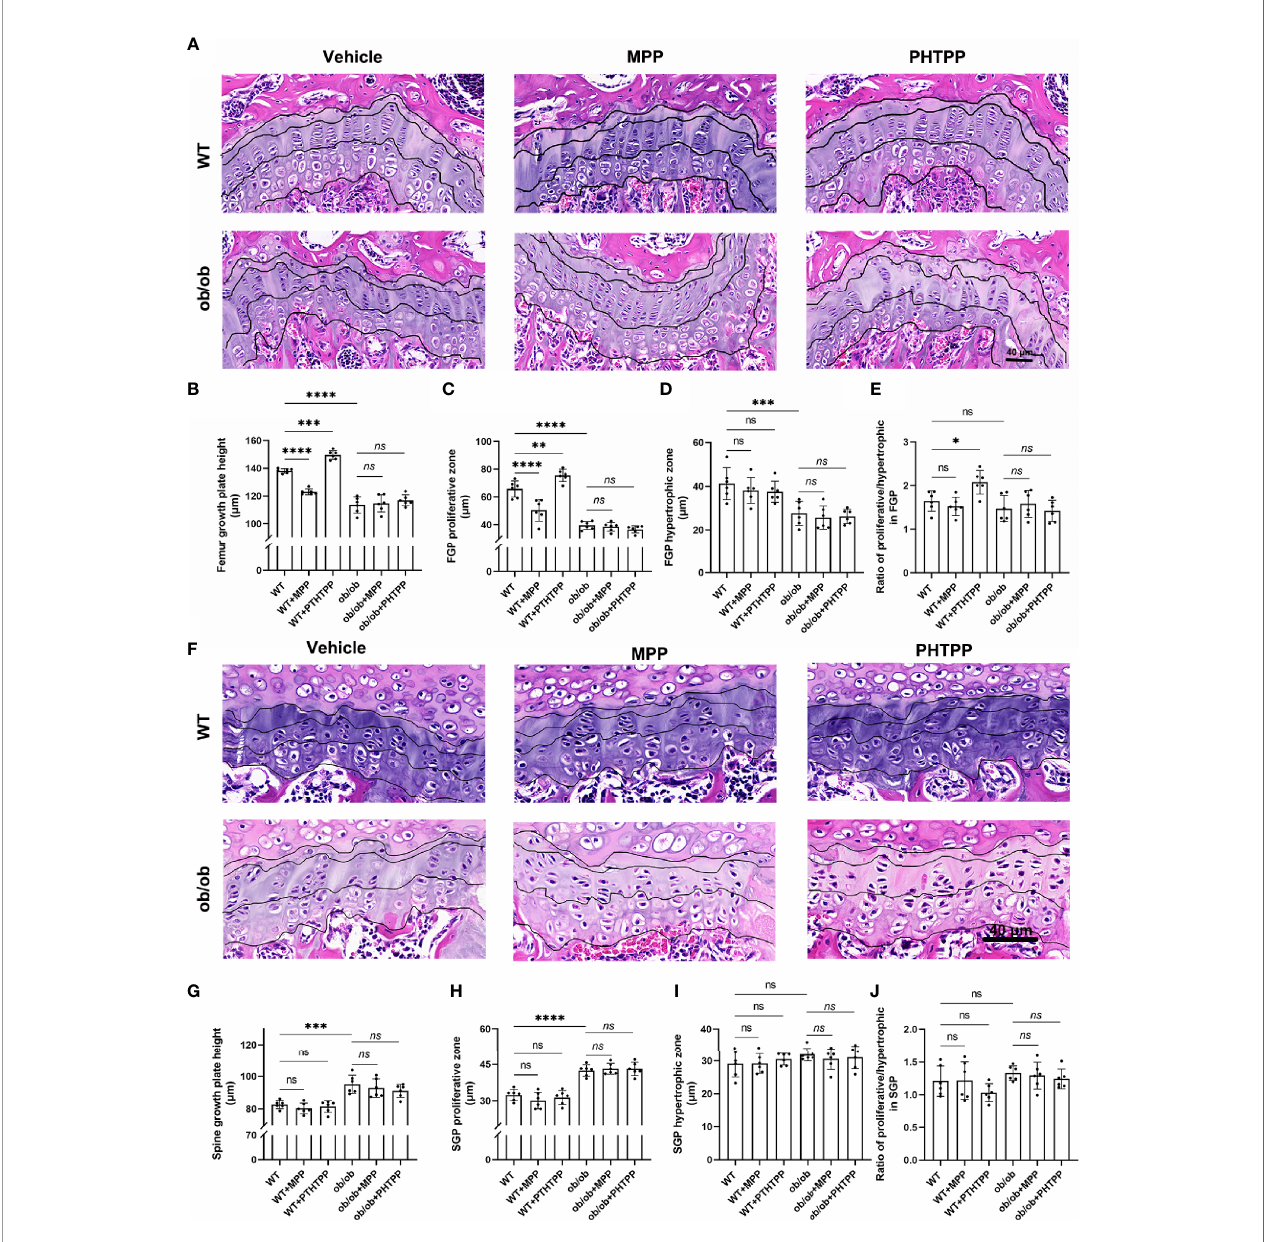
FIGURE 7 | Leptin de fi ciency disturbs the regulatory effects of estrogen receptor-selective antagonists on the femur growth plate (GP) thickness and proliferative and hypertrophic zone using H&E staining method (A – E) . (A) Femur GP H&E staining. (B) The height of GP in the femur GP. (C) The height of proliferative zone in the femur GP. (D) The height of hypertrophic zone in femur GP. (E) Ratios of proliferative/hypertrophic zones in femur GP. Leptin de fi ciency disturbs the regulatory effects of estrogen receptor-selective antagonists on the vertebral GP length, and proliferative and hypertrophic zone using H&E staining method (F – J) . (F) Vertebral GP H&E staining. (G) The height of GP in the vertebral GP. (H) The height of proliferative zone in the vertebral GP. (I) The height of hypertrophic zone in vertebral GP. (J) Ratios of proliferative/hypertrophic zones in vertebral GP. Scale bar: 40 m m; n = 6 each group. Values are means ± SD, * p < 0.05, ** p < 0.01, *** p < 0.001